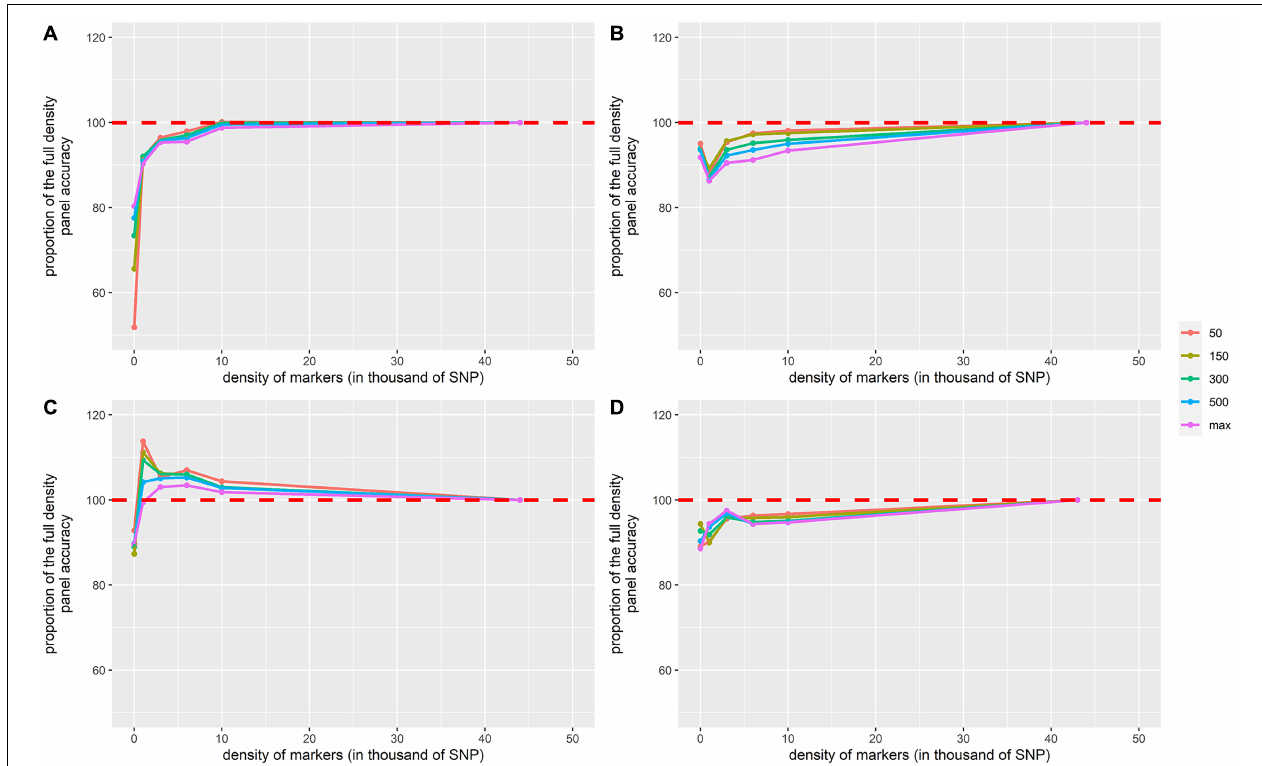
FIGURE 3 | Proportion of the full-density SNP panel accuracy for genomic breeding value estimates as a function of the density of markers in (A) European sea bass commercial cohort VNN_A challenged to NNV, (B) European sea bass commercial cohort VNN_B challenged to NNV, (C) European sea bass commercial cohort VIB challenged to V. harveyi , and (D) gilthead sea bream commercial cohort PAS challenged to Photobacterium damselae subsp. piscicida . The density of markers is expressed in thousands of SNPs. Only training population size of 50, 150, 300, 500, and 700 for PAS and 800 for others are displayed and represented by the color palette. Each point is the average of 100